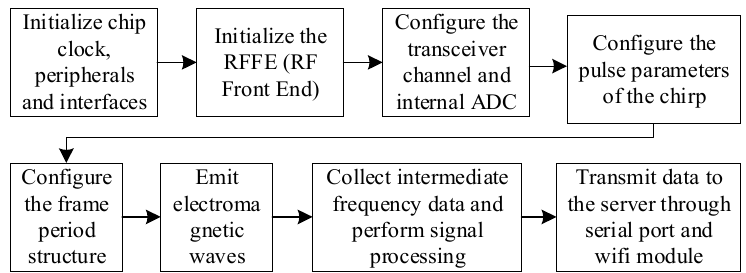
Figure 11. Software flow chart of millimeter wave radar module. Our system used a cloud service software architecture. The device did not need to be directly connected to the computer via a data cable. The data was sent directly to the server via Wi-Fi, and the server’s program calculated the monitored data in real time by unpacking and computing the socket data. The data was saved on the server, and the software obtained and displayed the parameters in real time through POST and GET methods. The software system architecture diagram based on cloud service is shown in Figure 12. Our cloud server used Alibaba Cloud’s ECS server, and the server uses Ubuntu 18.04 system. The algorithm was transplanted and packaged into a dynamic link library of the Linux system (.so file). The netty framework was used on the server side to realize real-time data unpacking and algorithm calculation and store it in the database. The server used the RESTFUL framework of node.js, and the computer software obtained the calcu- lated data through GET and post methods.